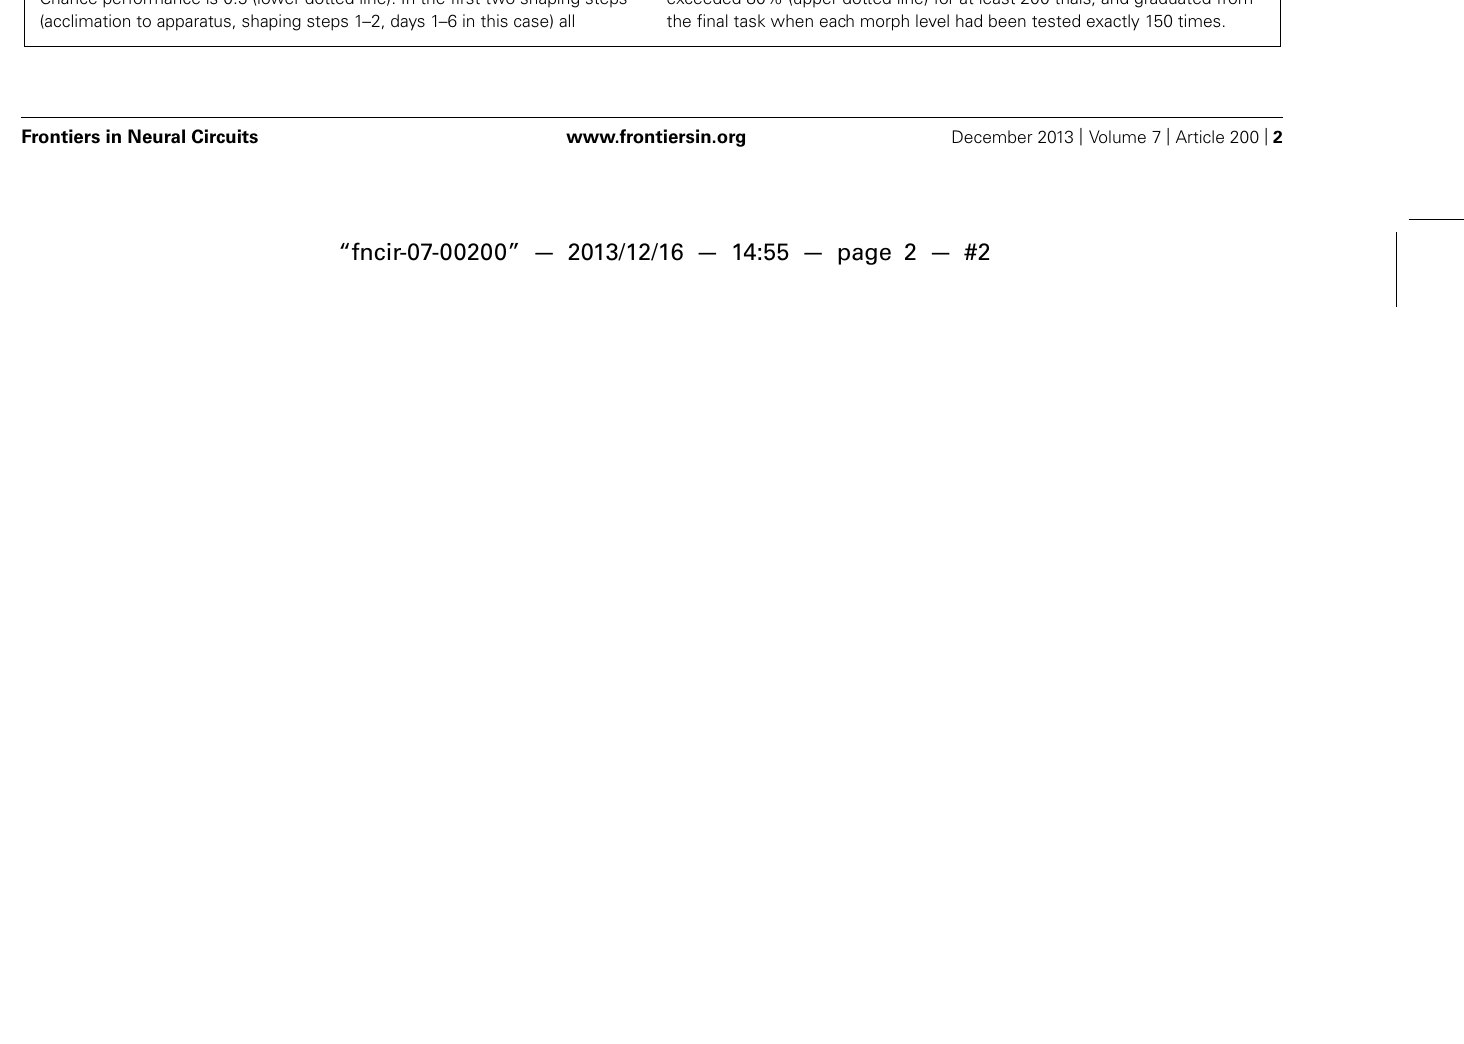
FIGURE 1 |Training and testing paradigm. (A) Diagram of cage-attached operant conditioning chamber. (B) One of the subjects in this study in the operant chamber performing the statue-shuttle image discrimination (shaping step 4). (C) The exemplar image pair E and examples of the intermediate morph pairs for the flashlight–paintbrush image discrimination used in the testing phase (shaping step 6). (D) Example learning curve for one subject showing performance as a course of training from naïve to study completion. Training day indicates number of calendar days since initiating training. Chance performance is 0.5 (lower dotted line). In the first two shaping steps (acclimation to apparatus, shaping steps 1–2, days 1–6 in this case) all